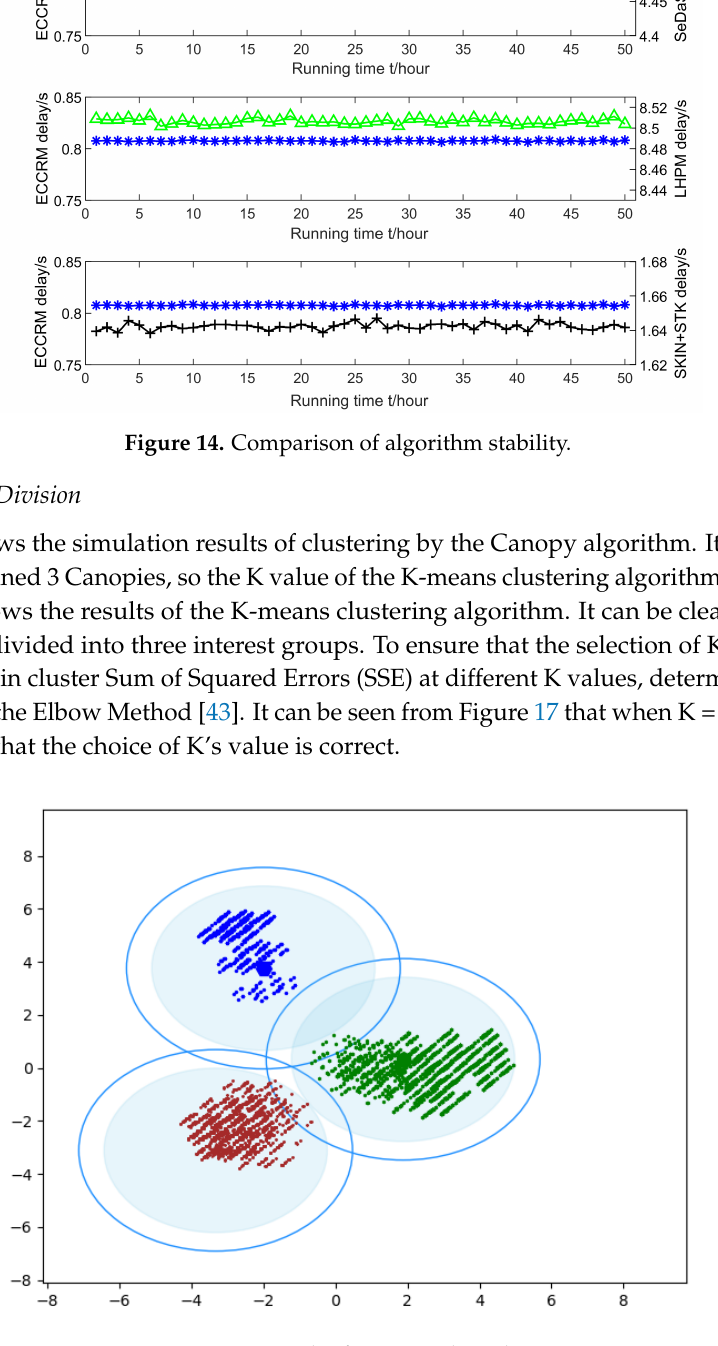
Figure 15. Result of Canopy